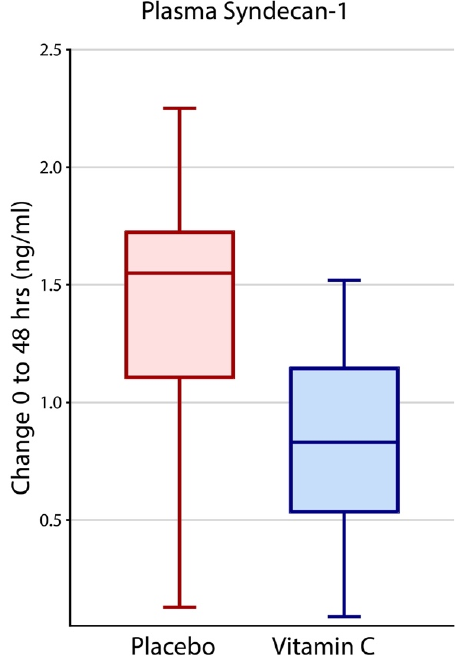
Figure 2. Forty-eight-hour increase in syndecan-1 in the two groups, Placebo and HDIVC. Median values, the top and bottom of the boxes show the interquartile range (IQR), whiskers show 95% confidence interval (CI). The extreme outliers outside the 95% confidence intervals have been omit- ted. 3.4. Effects of Plasma Syndecan-1 on 28-Day All-Cause Hospital Mortality Baseline syndecan-1 levels as well as both 48 h changes in cfDNA and syndecan-1 levels predicted 28-day all-cause mortality. Table 2 outlines the Odds Ratio (OR) of death for every incremental unit of the corresponding biomarker. Table 2. Effect of cfDNA and syndecan-1 on 28-day all-cause hospital mortality. Adjusted (multiple) logistic regression table outlining Odds Ratio (OR) of death for each incremental unit increase in baseline and 48 h change (delta, Δ ) of the plasma cfDNA and syndecan-1 levels. Predictor Odds Ratio p -Value 95% Confidence In- tervals Baseline syndecan-1, each unit increase, ng/ml